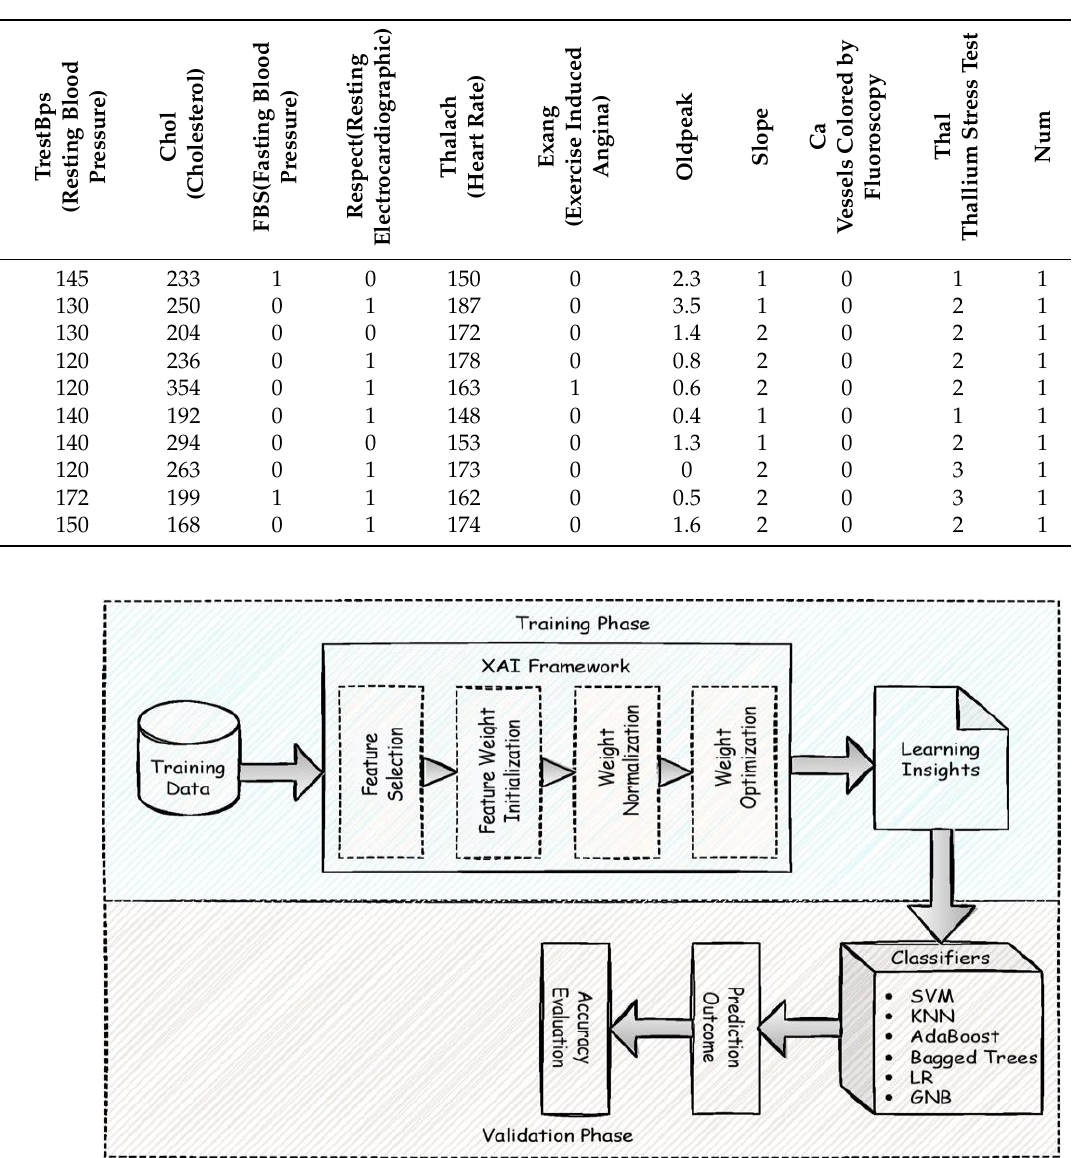
Figure 2. XAI framework in the feature processing for predicting heart disease.